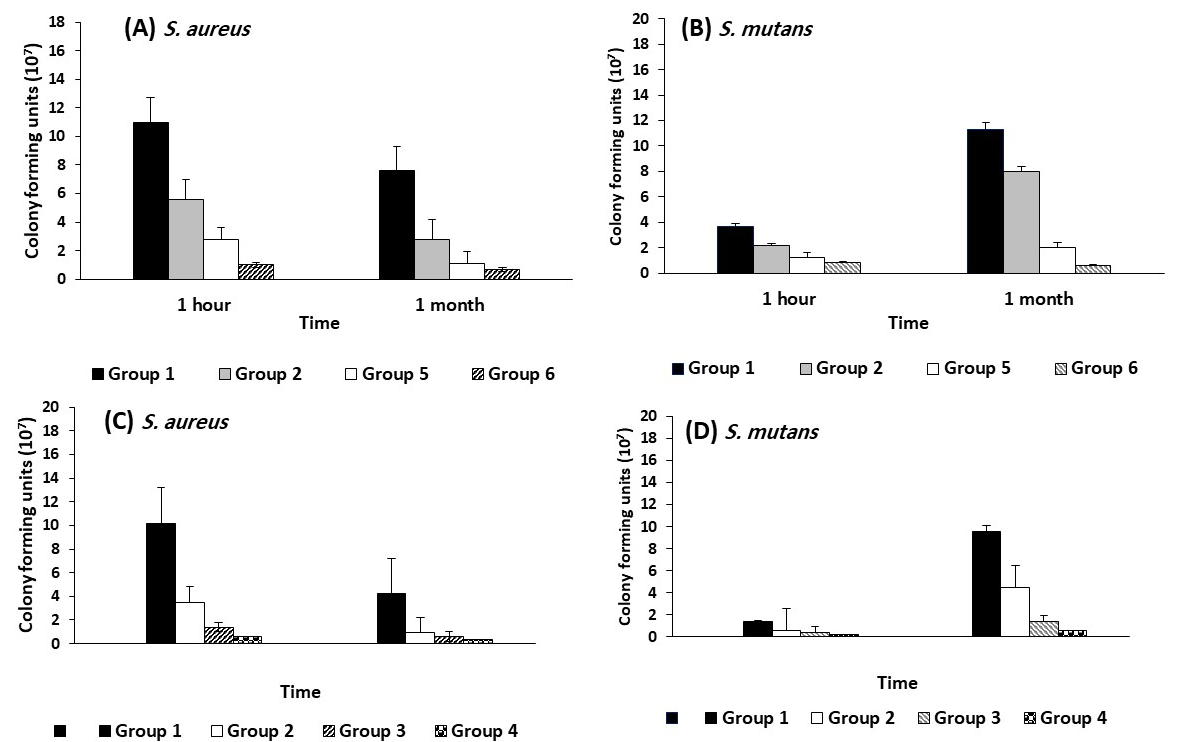
Figure 8. Number of CFU normalized to the control after one hour MDCT on the modified GIC cement and modified GIC cement after one month in suitable media ( n = 3). 1—(Group 1) GIC; 2—(Group 2) 98.5% GIC with 1.5% metronidazole, 3—(Group 3) 99.5% GIC with 0.5%